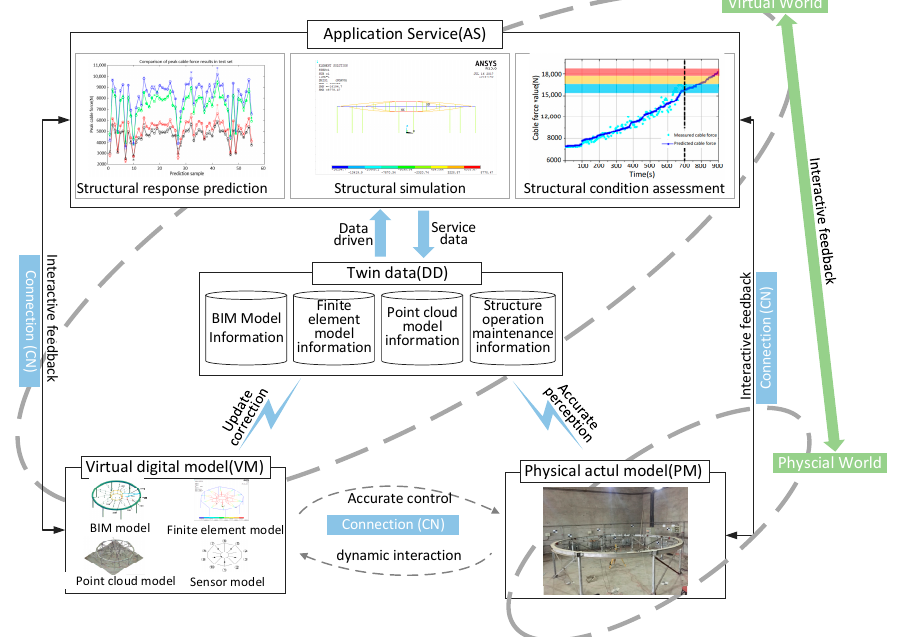
Figure 2. The DTs-OMS model of prestressed steel structure. 3.2. Framework for Impact Response Prediction of Prestressed Steel Structures The framework for impact response prediction of prestressed steel structure mainly includes the physical layer, perception layer, transmission layer, analysis layer, and ser- vice layer (as shown in Figure 3).